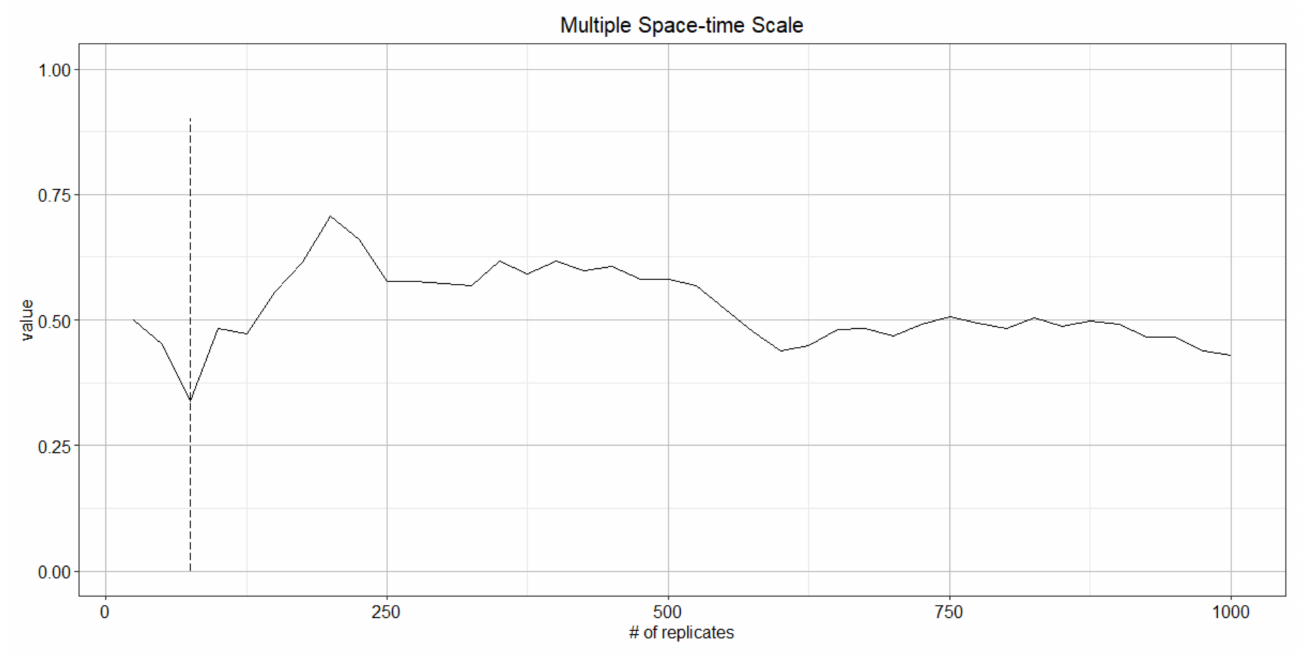
Figure 7. The change of the average of CVs over the number of